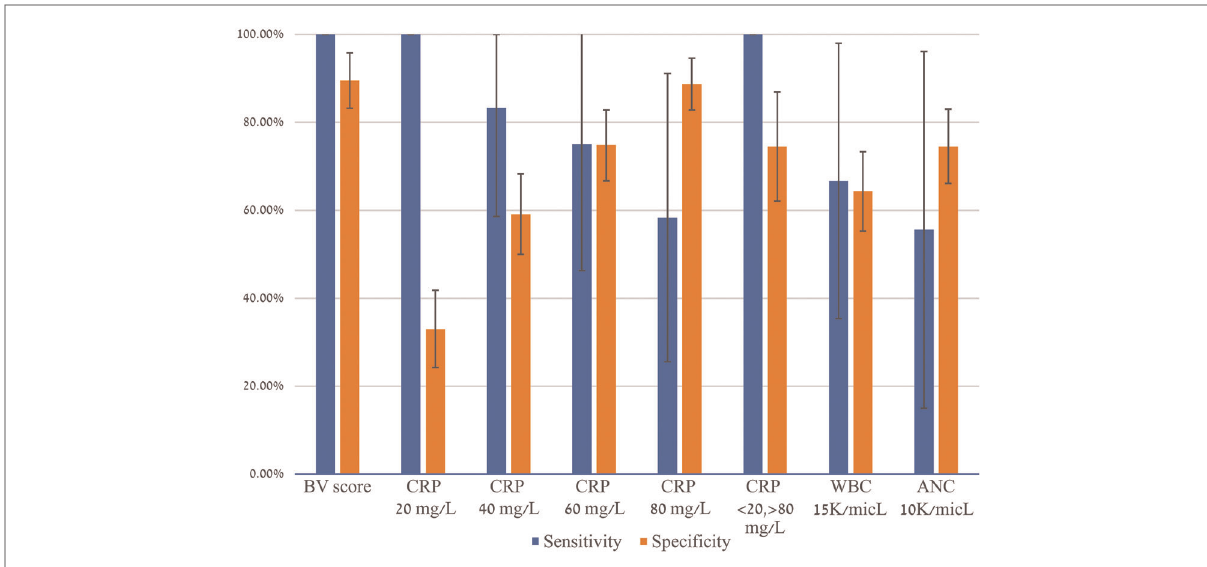
FIGURE 2 BV score comparison to routine biomarkers. Error bars indicate 95% con fi dence intervals. The equivocal rate was 19.7% for BV score and 54.3% for CRP 20/80. CRP, C-reactive protein; WBC, white blood cells; ANC, absolute neutrophil